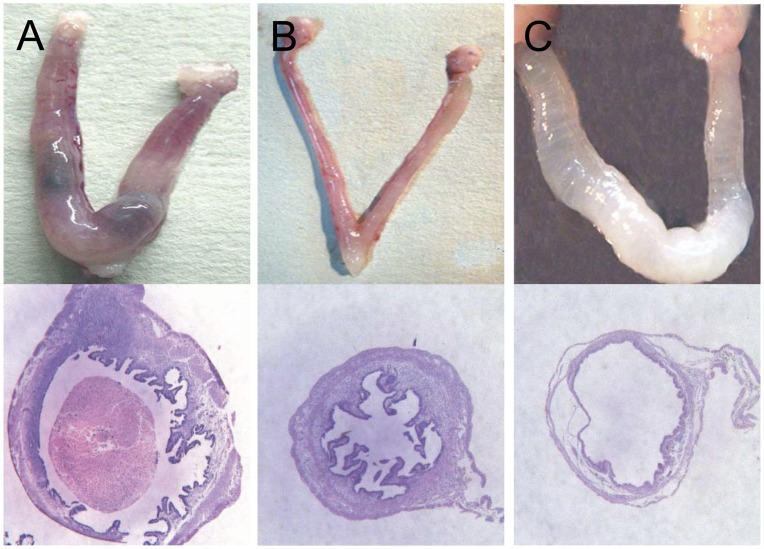
Macroscopic and microscopic structure of the uterus at 48 h after treatment with different dosages of RU 486.On day 8.5 of pregnancy, mice were treated with 3 different doses (0.3, 2, or 20 mg/kg) of RU 486. Uterine tissues were examined 48 h after the treatment. (A) Treatment with 0.3 mg/kg RU 486 caused termination of pregnancy in 60% of mice (3/5). The weight of the uterus increased, and the abortion was incomplete. (B) Treatment with 2 mg/kg RU 486 caused termination of pregnancy in 100% of cases, and the aborted horn completely regenerated. (C) Treatment with 20 mg/kg RU 486 caused pregnancy loss in 100% of mice and led to uterine dropsy (fluid retention: 3/5 mice [60%]). Therefore, the 2 mg/kg dosage was considered optimal for inducing abortion.